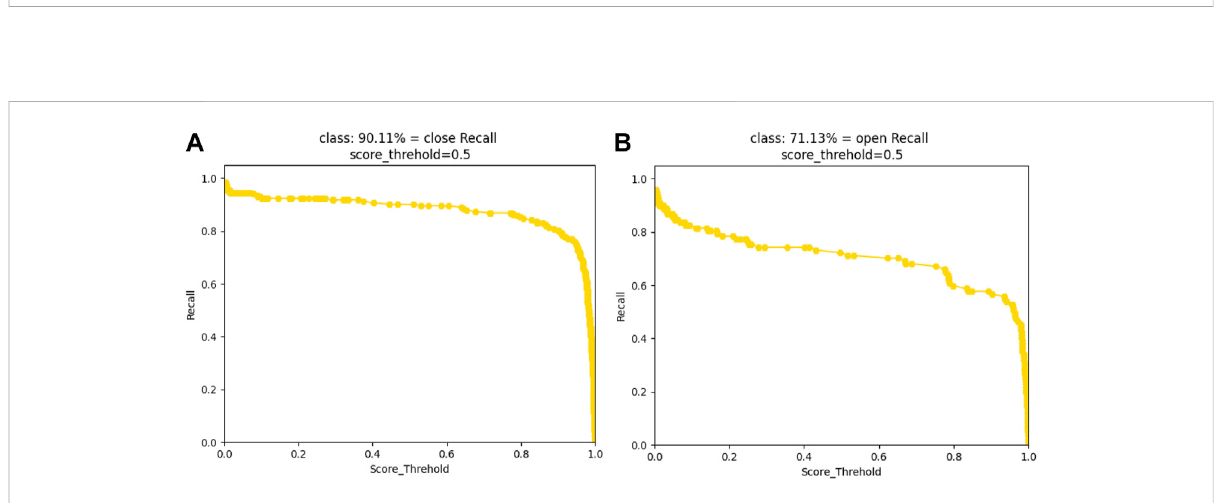
FIGURE 8 Recall of improved YOLOv4 model. (A) close recall; (B) open recall.